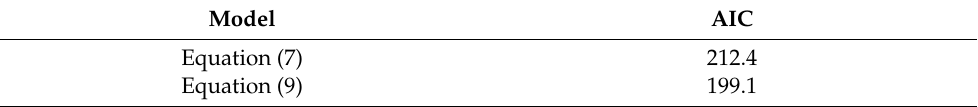
Table 7. Akaike Information Criterion (AIC) of binomial nonlinear regression models for predicting stand density.